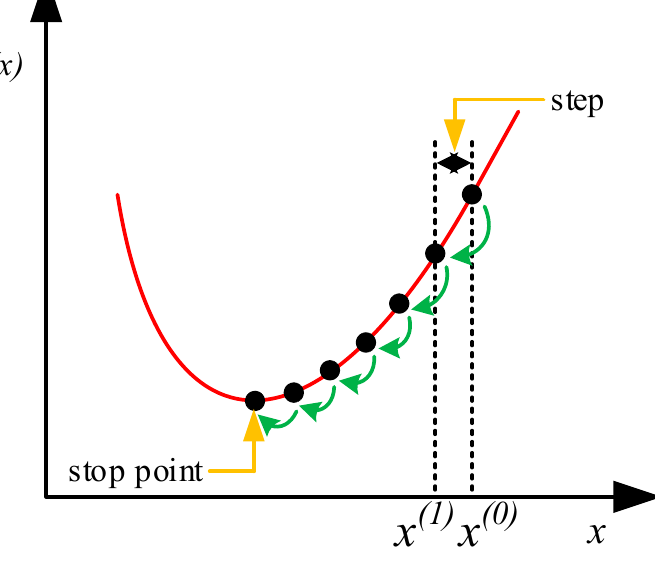
Energies 2019 , 12 , x FOR PEER REVIEW Figure 3. Example of a gradient search for a stationary point. Figure 3. Example of a gradient search for a stationary point.